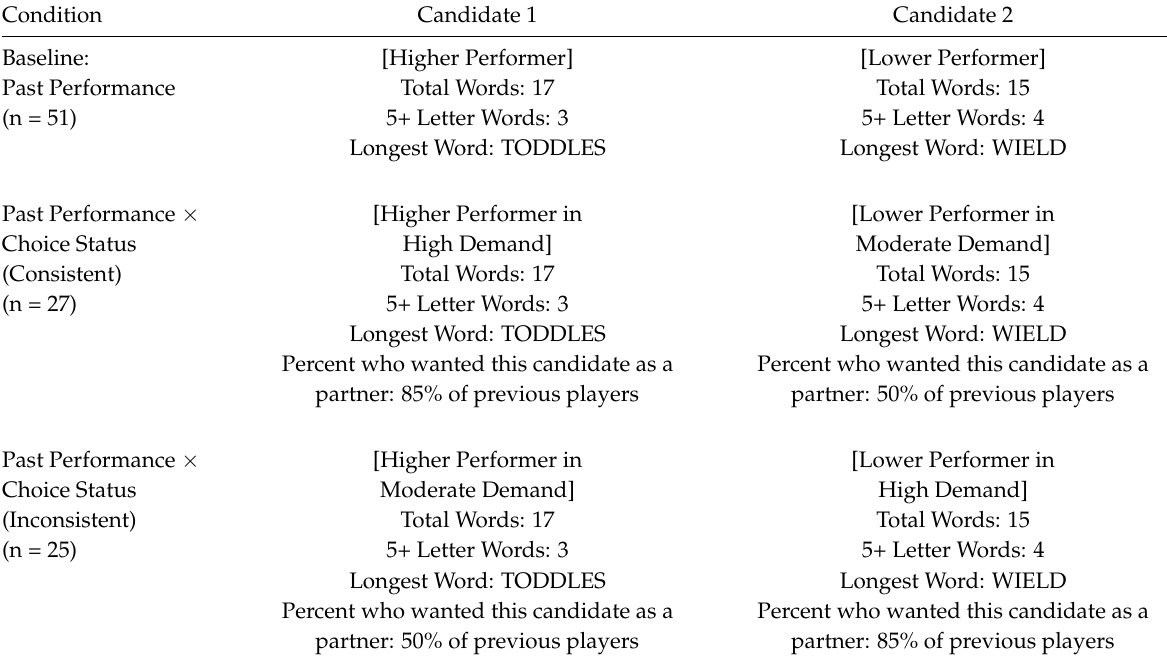
Table 1: Summary of Conditions in Study 1